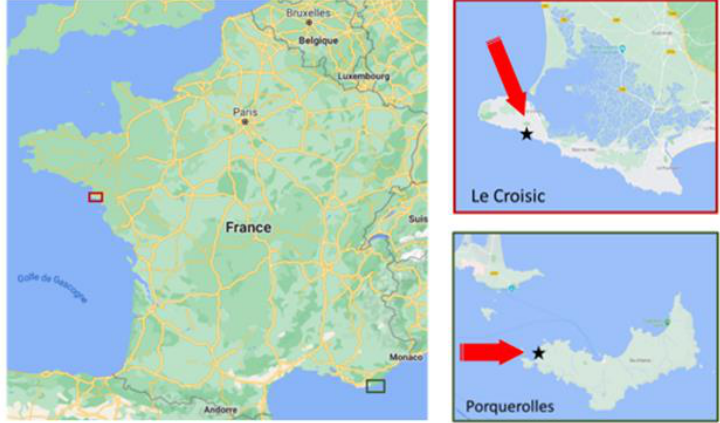
Figure 1. Geographical position of the two sampling sites (the stars).